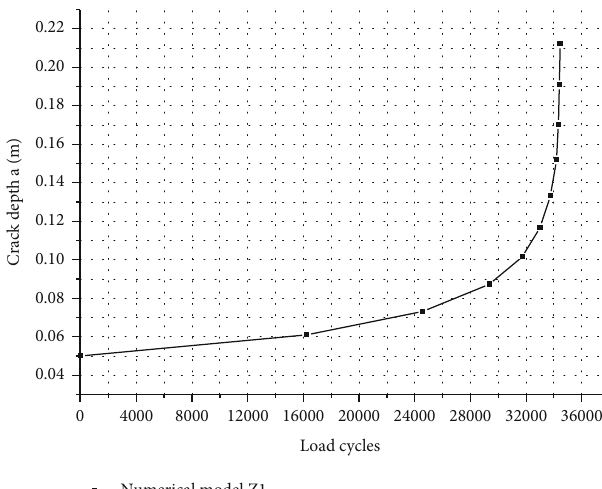
Figure 10: Crack length in depth versus number of load cycles up to failure for numerical model